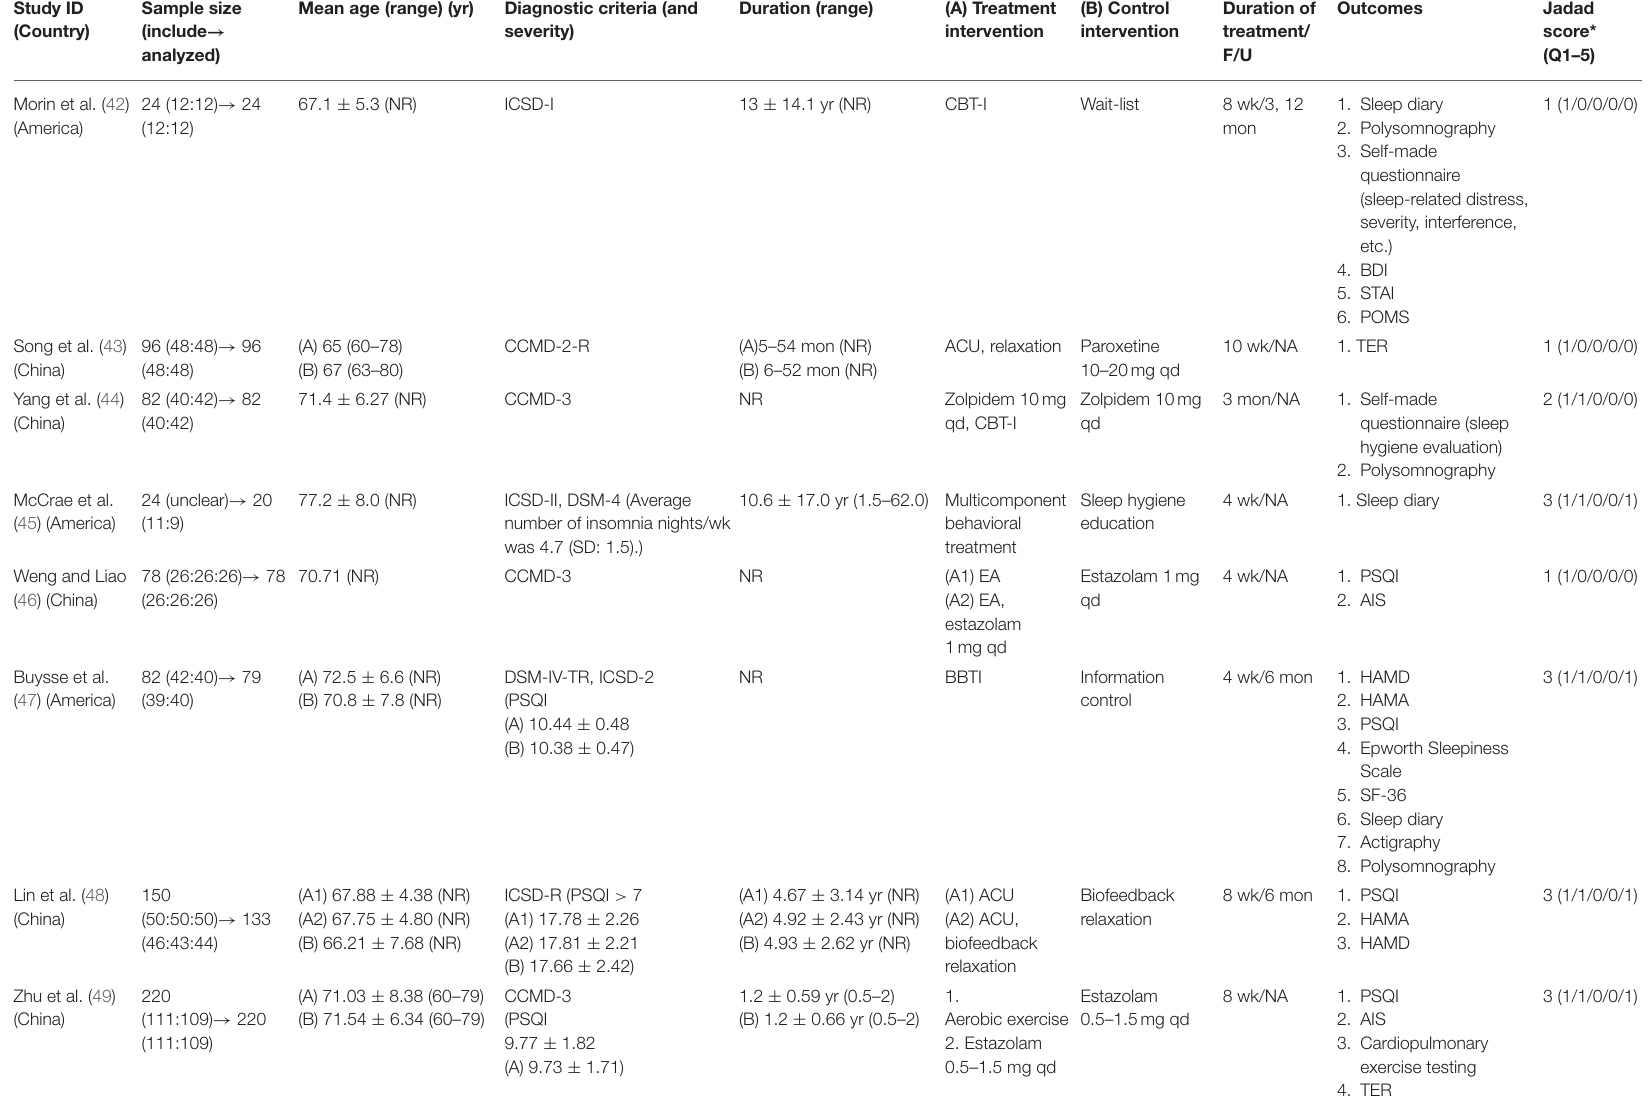
TABLE 1 | Characteristics of included randomized controlled